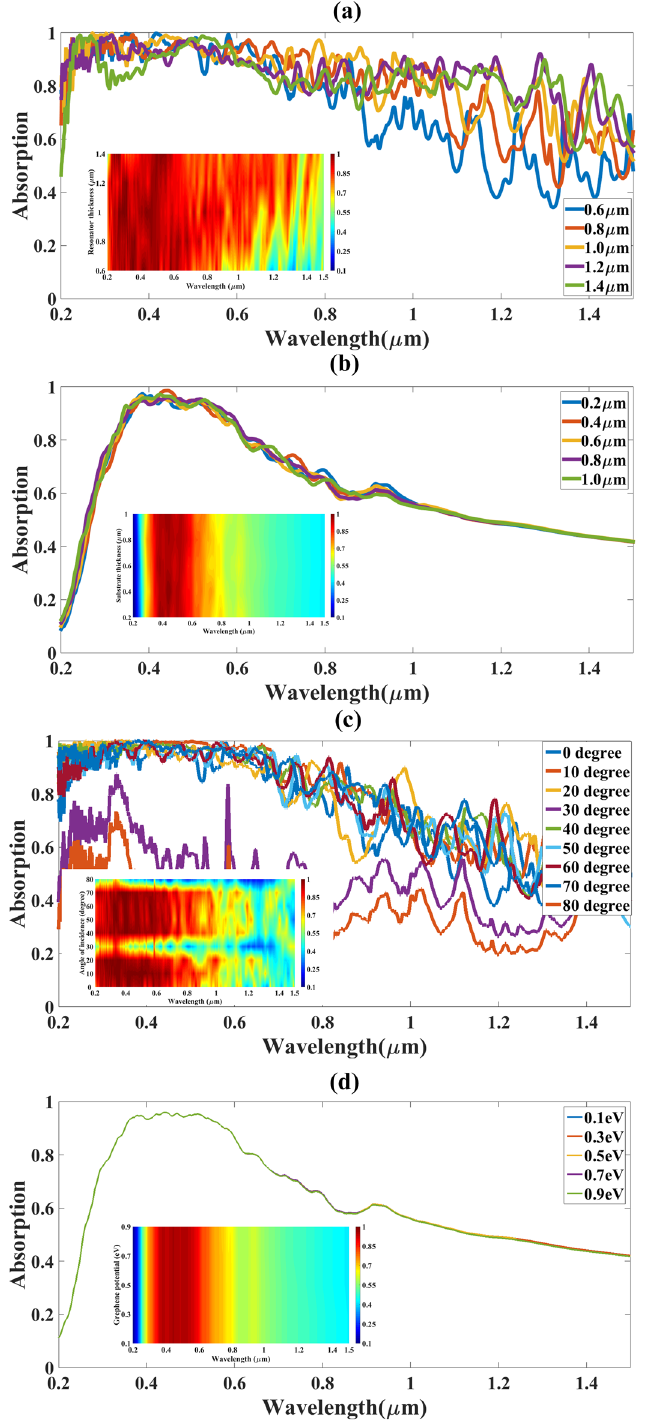
Figure 4. Absorption response of graphene-based O-shape metasurface absorber for ( a ) Different resonator thicknesses (0.6 to 1.4 µm). ( b ) Different substrate thicknesses (0.2 to 1 µm). ( c ) Difference angles of incidence (0° to 80°). ( d ) Different graphene’s chemical potential (0.1 to 0.9 eV. The inset shows the color plot of absorption for different resonator/substrate thickness/angle of absorption/graphene chemical potential for the wavelength range of 0.2 to 1.5